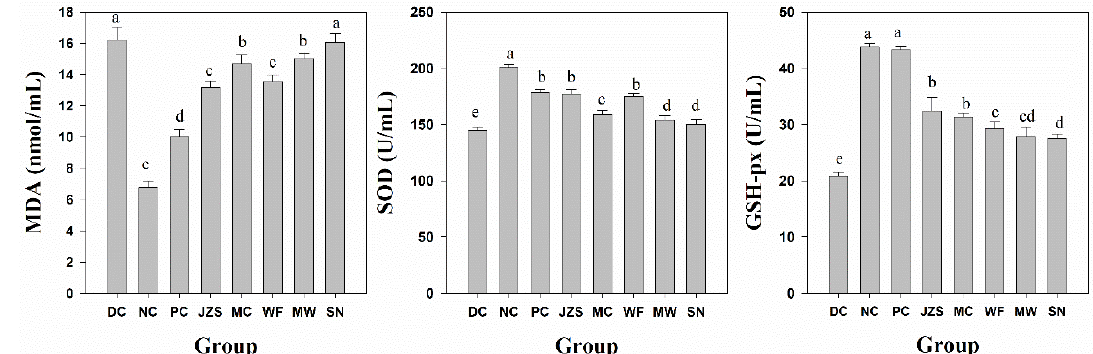
Figure 4. Antioxidant index of C. paliurus phenolics from sampling locations (JZS, MC, WF, MW, and SN) in diabetic model mice. Columns having different letters are significantly different at p < 0.05. DC: diabetic control group; NC: normal control group; PC: positive control group.